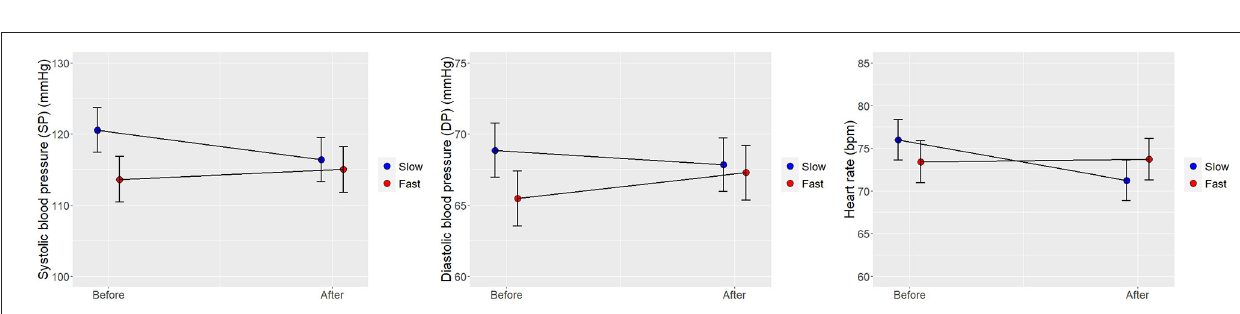
FIGURE 4 | Interaction plots of estimated marginal means with SEM error bars between the time points and walking sites.